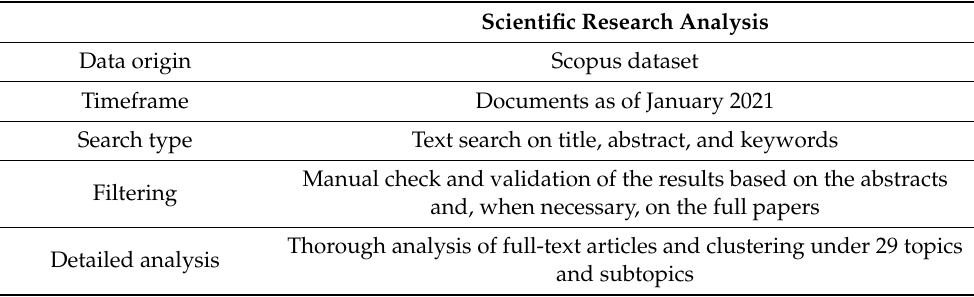
Table 1. Scientific analysis coverage overview (source: own